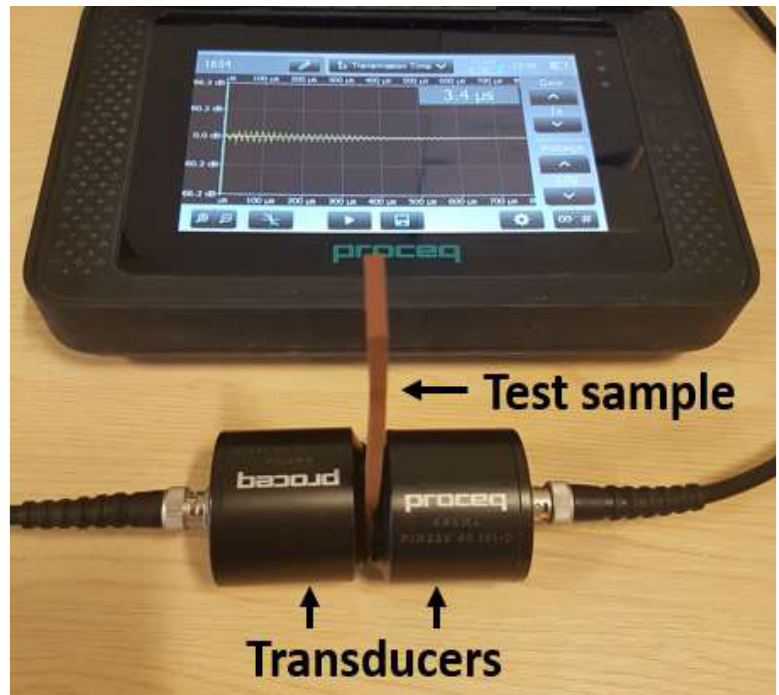
Figure 4. Ultrasonic testing of the FFF-printed samples.